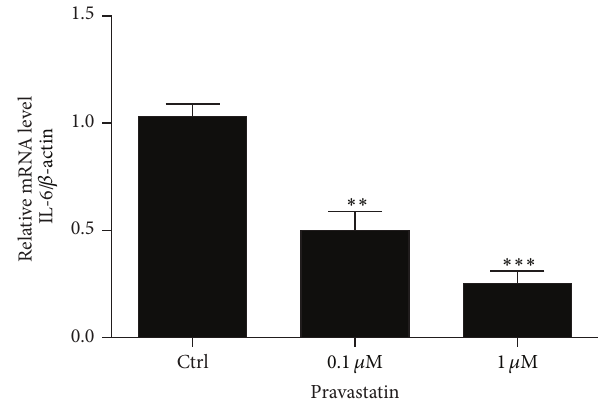
Figure 2: Pravastatin reduced IL-6 mRNA expression in HUVECs. The values represent the means ± SDs ( 𝑛 = 4 in each group). ∗∗ 𝑝 < 0.01 versus Ctrl group. ∗∗∗ 𝑝 < 0.001 versus Ctrl